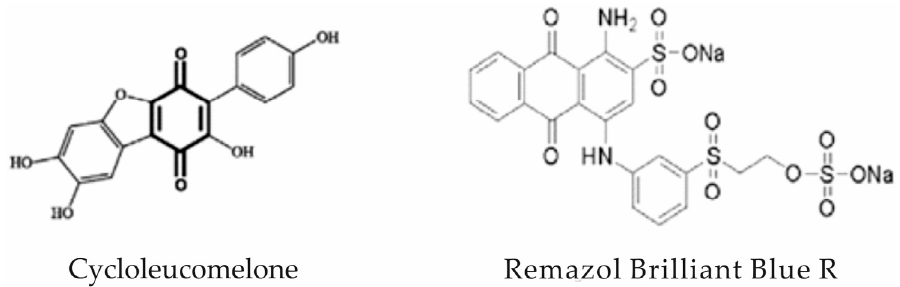
Figure 7. Fungal pigment cycloleucomelone and anthraquinone dye RBBR.